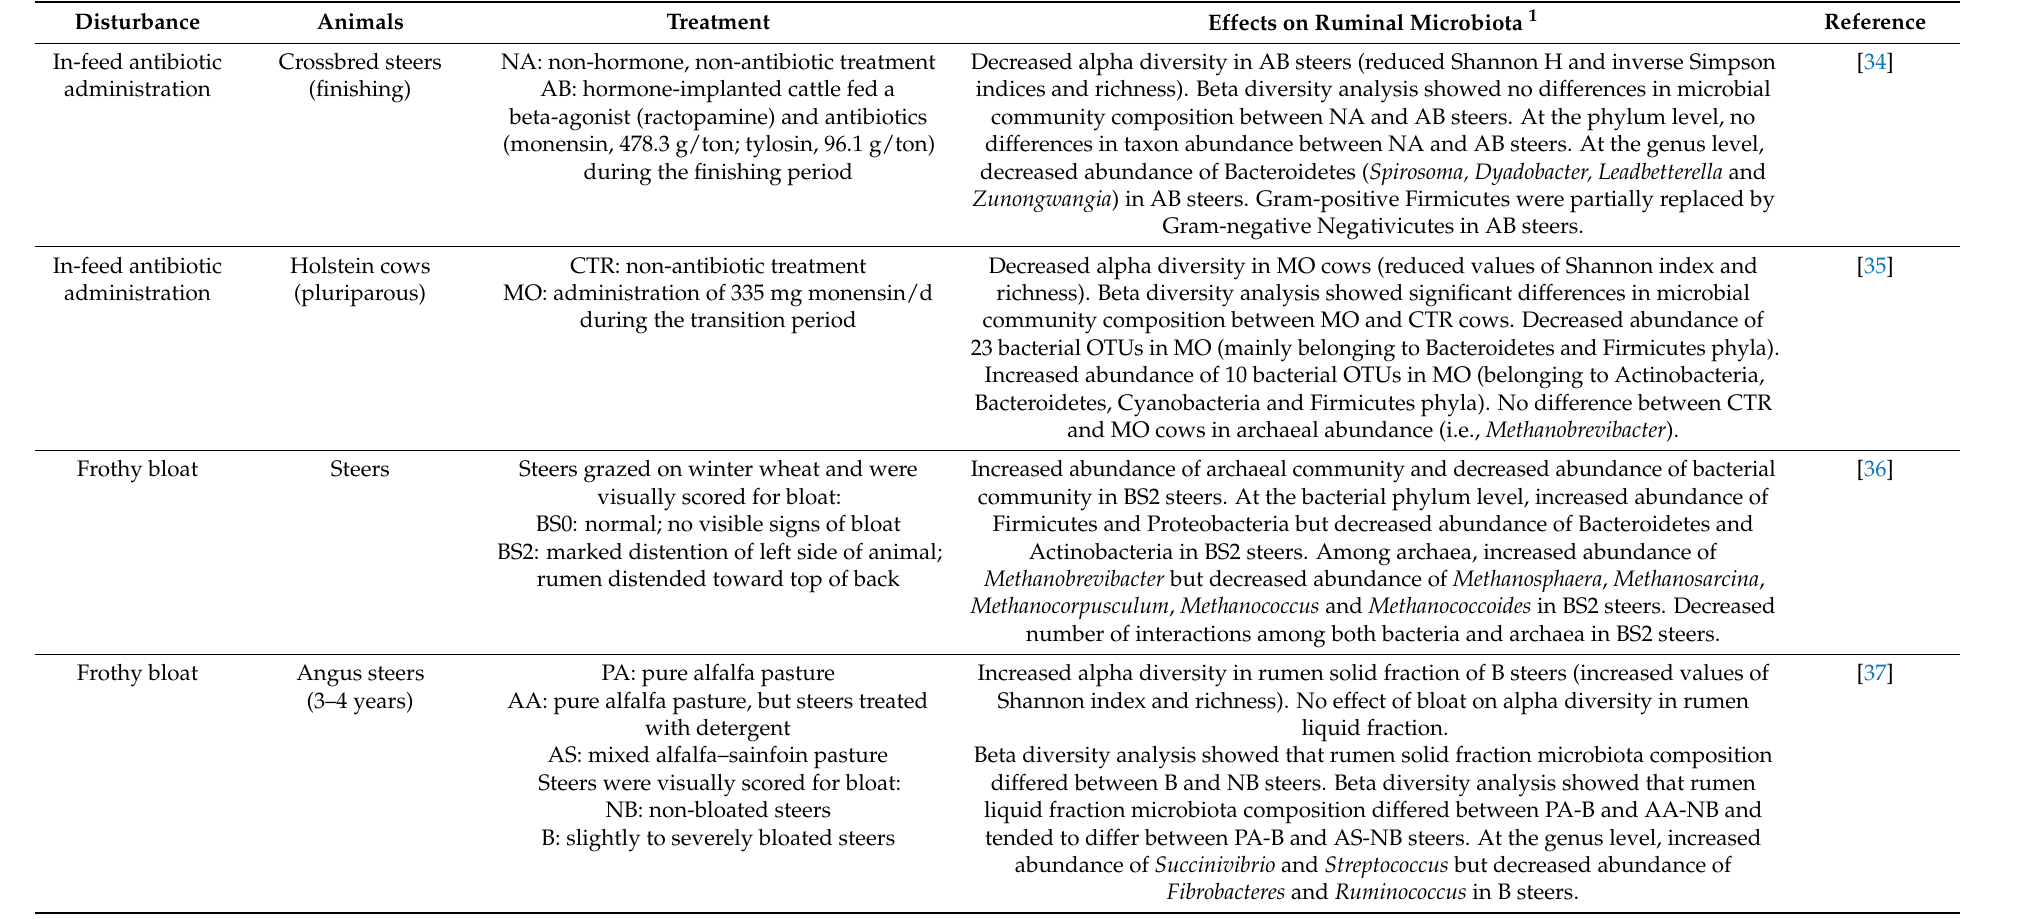
Table 1. Main effects of pulse disturbances on ruminal microbiota (bacteria and